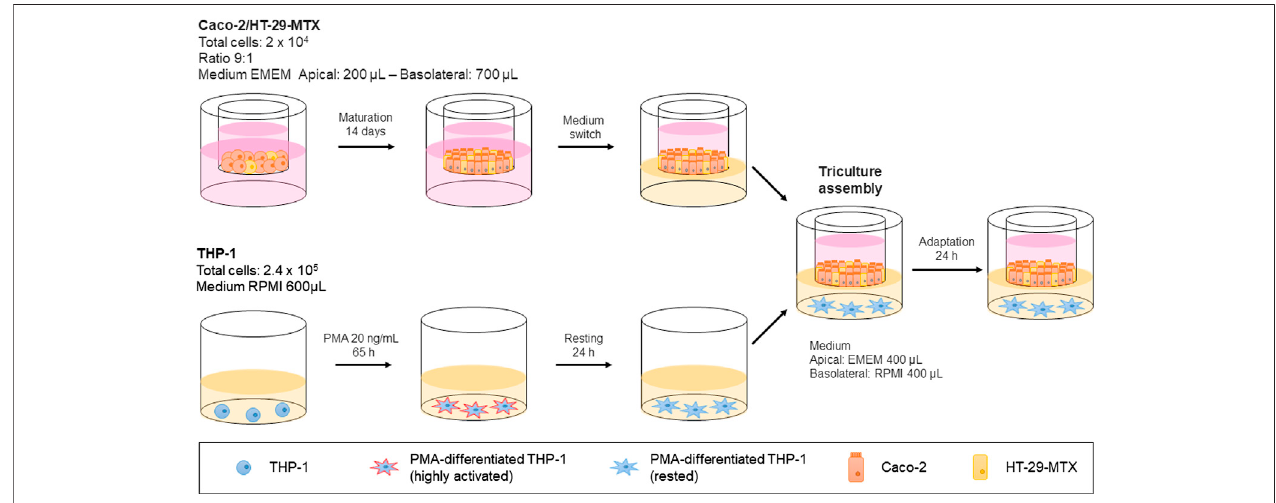
FIGURE 4 | Schematic representation of the triculture assembly